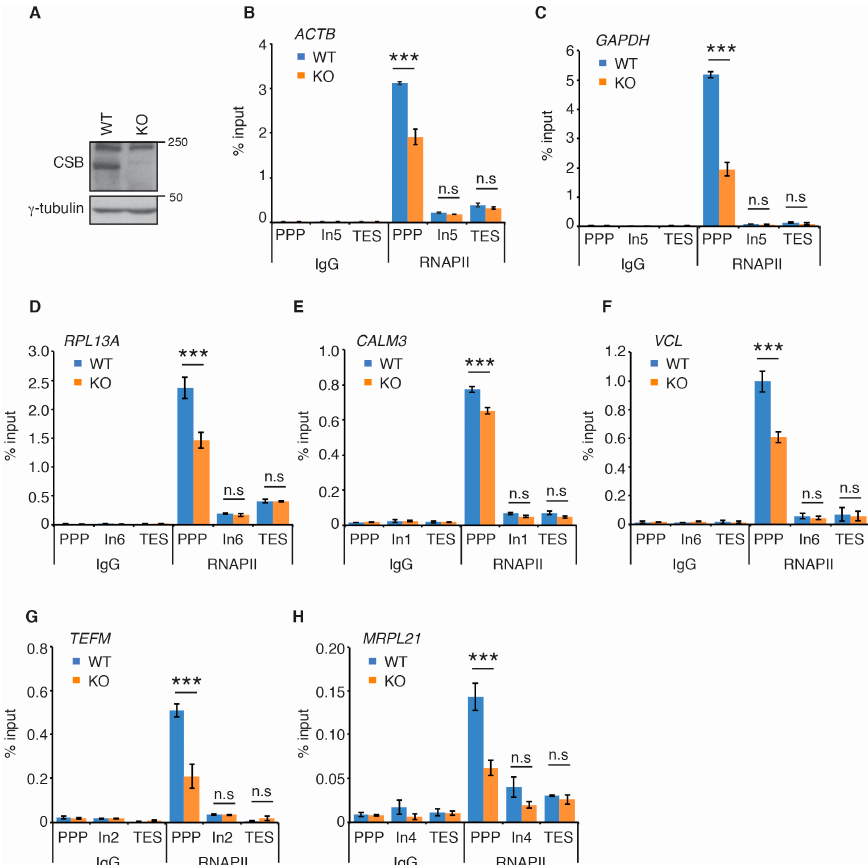
Figure 1. Loss of CSB impairs RNAPII occupancy at PPP sites. ( A ) Western analysis of U2OS CSB-WT and CSB-KO cells. Immunoblotting was performed with anti-CSB and anti- γ -tubulin antibodies. The γ -tubulin blot was used as a loading control in this and subsequent figures. ( B–H ) RNAPII ChIP analyses of ACTB , GAPDH , RPL13A , CALM3 , VCL , TEFM and MRPL21 genes in U2OS CSB-WT and CSB-KO cells. Standard errors from three independent experiments are shown. p values were derived using the 2-way ANOVA test. *** p < 0.001, n.s.: not significant. Abbreviations used in